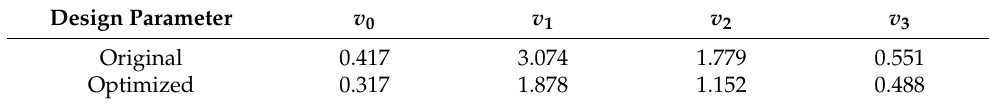
Table 3. Parameters before and after arc optimization of diagonal flow fan blade. Design